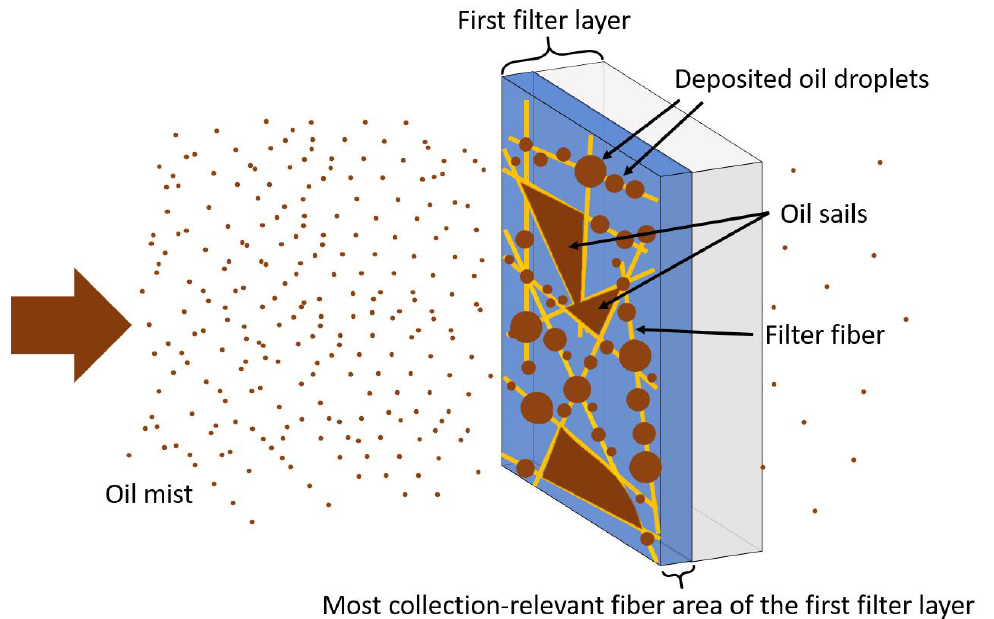
Figure 2. Schematic illustration highlighting the very first fiber layers, which are most collection- relevant (blue area) on the front face of the first filter layer (blue and grey area) of a multi-layer filter medium. Deposited oil droplets on fibers and oil sails between adjacent fibers are marked. Direction of air flow is indicated by the